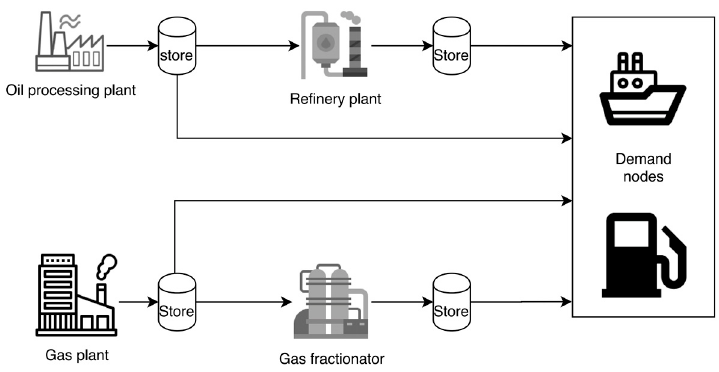
Figure 1. Schematic representation of downstream oil and gas supply chain.